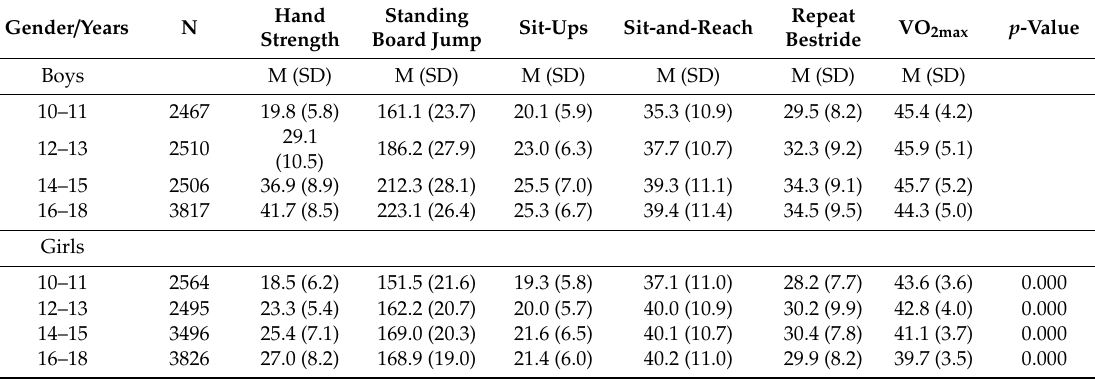
Table 2. Physical fitness tests, means, and standard deviations for sex and age